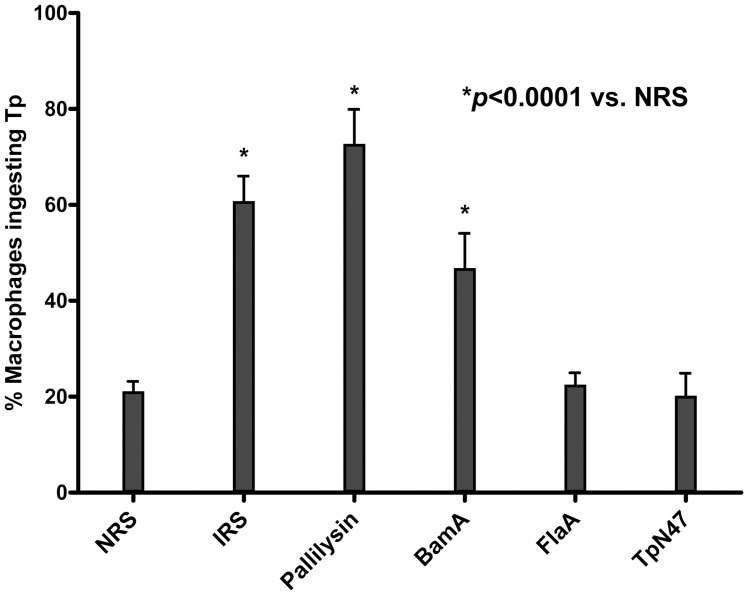
Pallilysin is a target of opsonic antibodies.
Treponema pallidum was incubated with either normal rabbit serum (NRS), immune rabbit serum (IRS) (positive control), or polyclonal antiserum specific for pallilysin, BamA (positive control), FlaA (negative control), or TpN47 (negative control) and the percentages of rabbit macrophages phagocytosing T. pallidum (Tp) were calculated. Mean opsonization percentages from a minimum of 5 replicates are presented with bars indicating standard error (SE). For statistical analyses, opsonization of T. pallidum following exposure to each of the antisera was compared to T. pallidum opsonization after incubation with NRS using the Student's two-tailed t test. Exposure of T. pallidum to the two positive control antisera (BamA and IRS) and pallilysin-specific antiserum resulted in statistically significant levels of T. pallidum opsonization (p<0.0001) when compared to the level of T. pallidum opsonization observed following incubation with NRS (indicated by *).